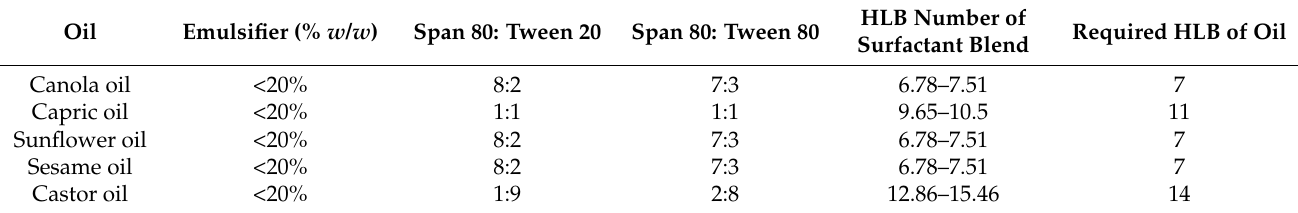
Table 1. Combination of ingredients tested for emulsion system.